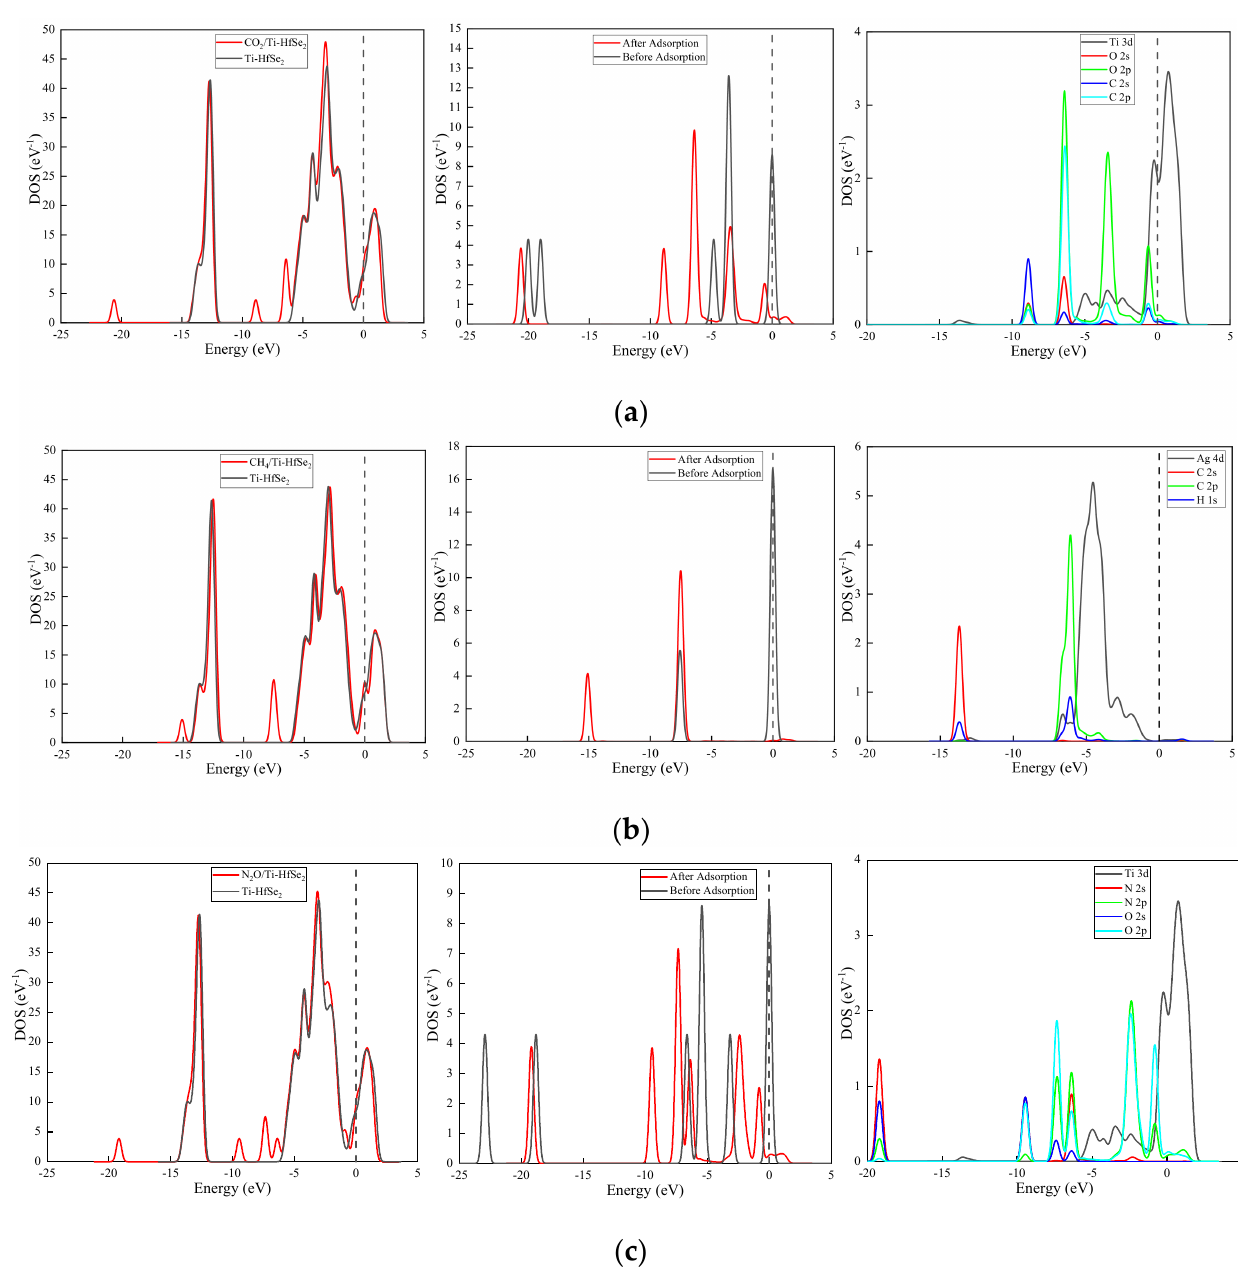
Figure 8. DOS and PDOS of adsorption system. ( a ) CO 2 adsorption system; ( b ) CH 4 adsorption system ( b ); ( c ) N 2 O adsorption system.